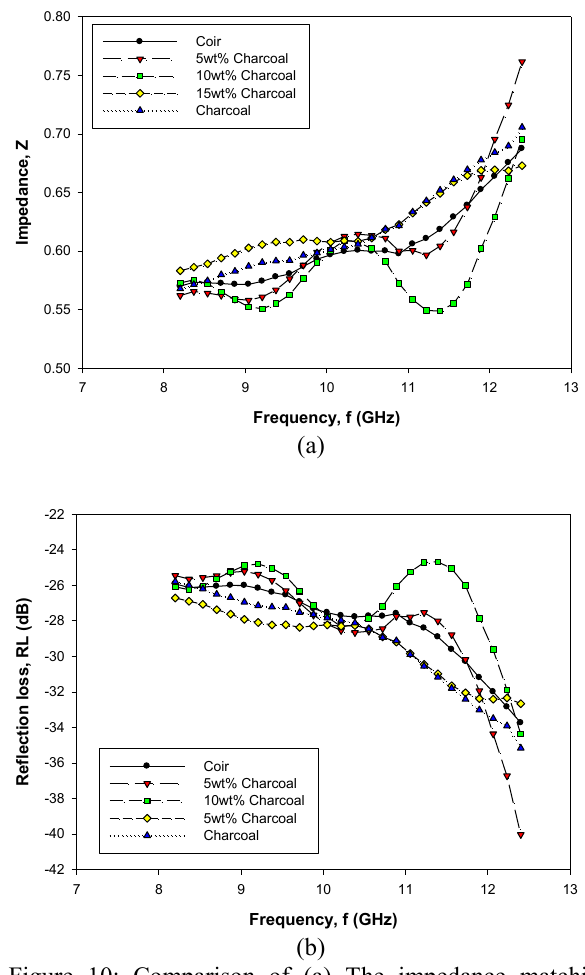
Figure 10: Comparison of (a) The impedance matching characteristic, (b) Reflection loss of five samples over the x- band frequency Table 2: The average of absorption properties over the x-band